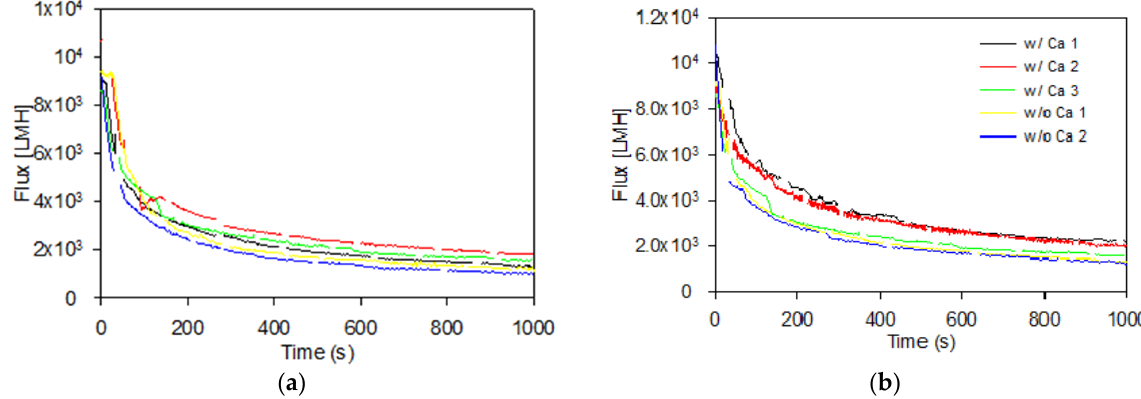
Figure 4. Decline in relative flux during 1000 s membrane fouling by filtration of low surface charge ( a ) and high surface charge ( b ) PS–PAA particles with and without calcium ions. Line breaks in the curves are caused by emptying the permeate beaker.